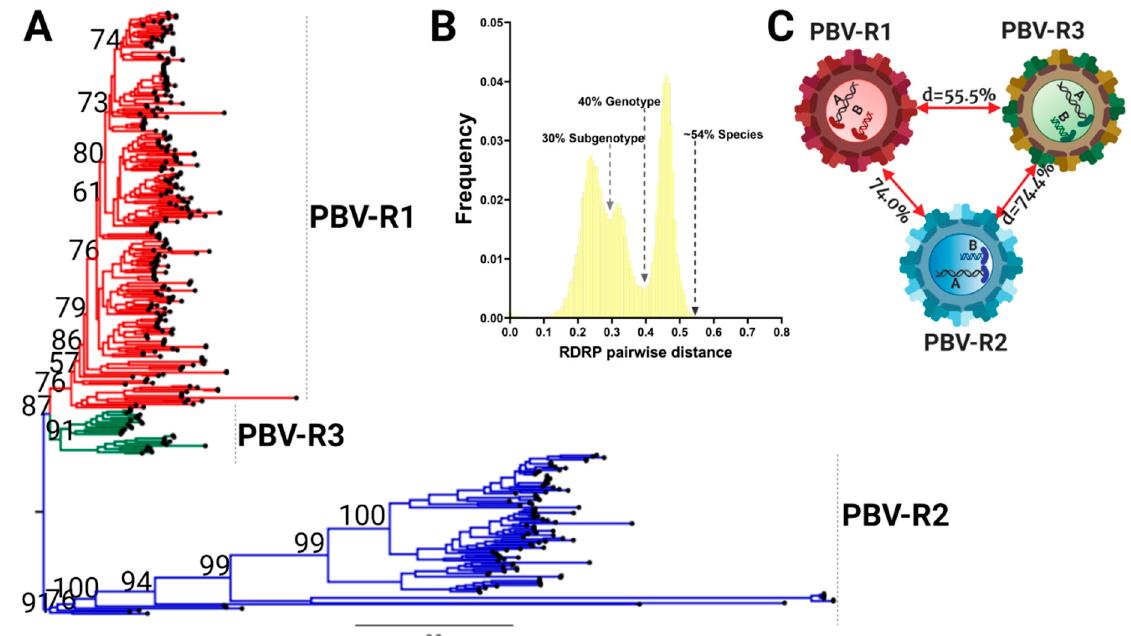
Figure 4. The Picobirnavirus genus differentiates into three species based on the RdRp coding region. ( A ) Phylogenetic tree based on the complete coding sequence of RdRp for all 403 non-redundant genomes available at GenBank and the maximum likelihood (ML) method using the LG + F + R10 model. The main PBV lineages were given the following designations and colors: PBVR1, red; PBVR2, blue; PBVR3, green). All the nodes with statistical support determined by bootstrap values higher than 60% are shown. ( B ) PASC results for the frequency distribution of pairwise distances for all 403 RdRp sequences. Cut-off values for each minor and major division is indicated, with a subgenotype at 30%, genotype at 40%, and different species at 54%. ( C ) Genetic distances for all three main lineages.